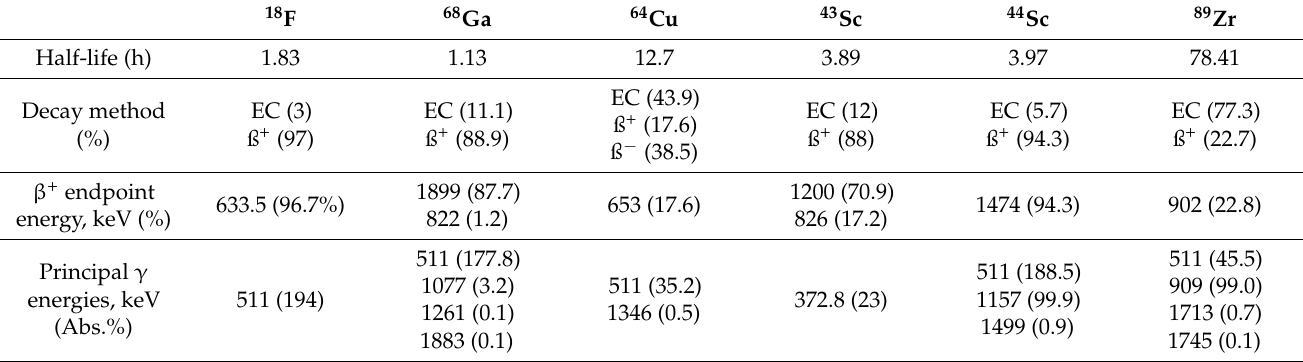
Table 2. Physical characteristics of commonly used PET